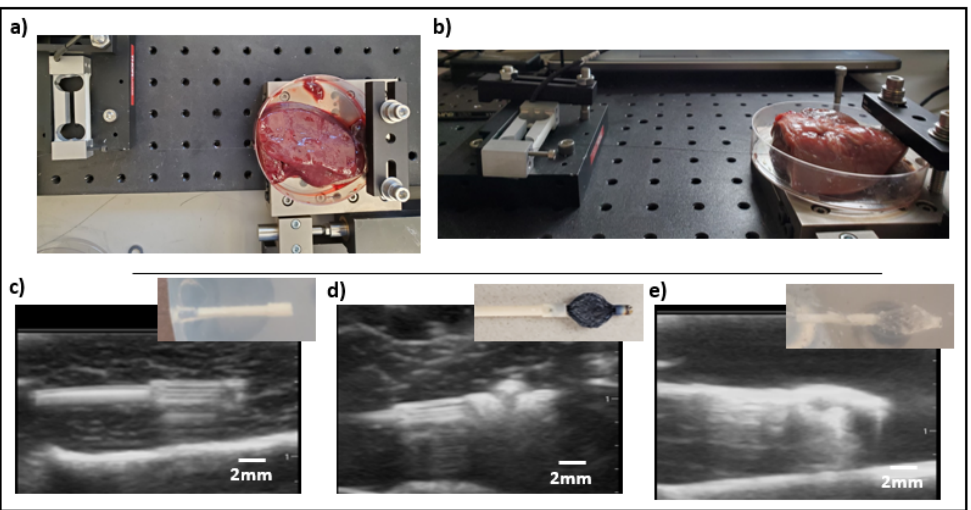
Figure 4. Representative force testing set-up in liver ( a ) and kidney ( b ) samples. Non-anchored ( c ), nitinol-anchored ( d ), and hydrogel-anchored ( e ) microdevices are well seen by ultrasound in all tissues at the implanted depths. Insets show the actual appearance of each device corresponding to its ultrasound image. Ultrasound was used to monitor for microdevice dislodgement in all solid tissues.